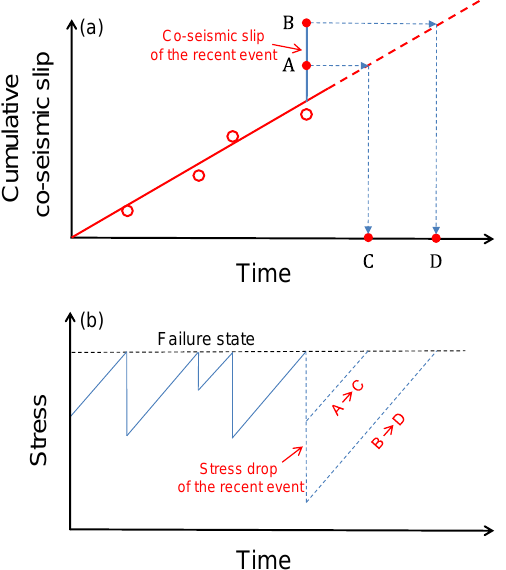
Figure 1. Schematic diagram for the time-predictable model: (a) best-estimate relationship between cumulative coseismic slips and time, and (b) the earthquake-time prediction facilitated with a failure state and a constant stress increment.